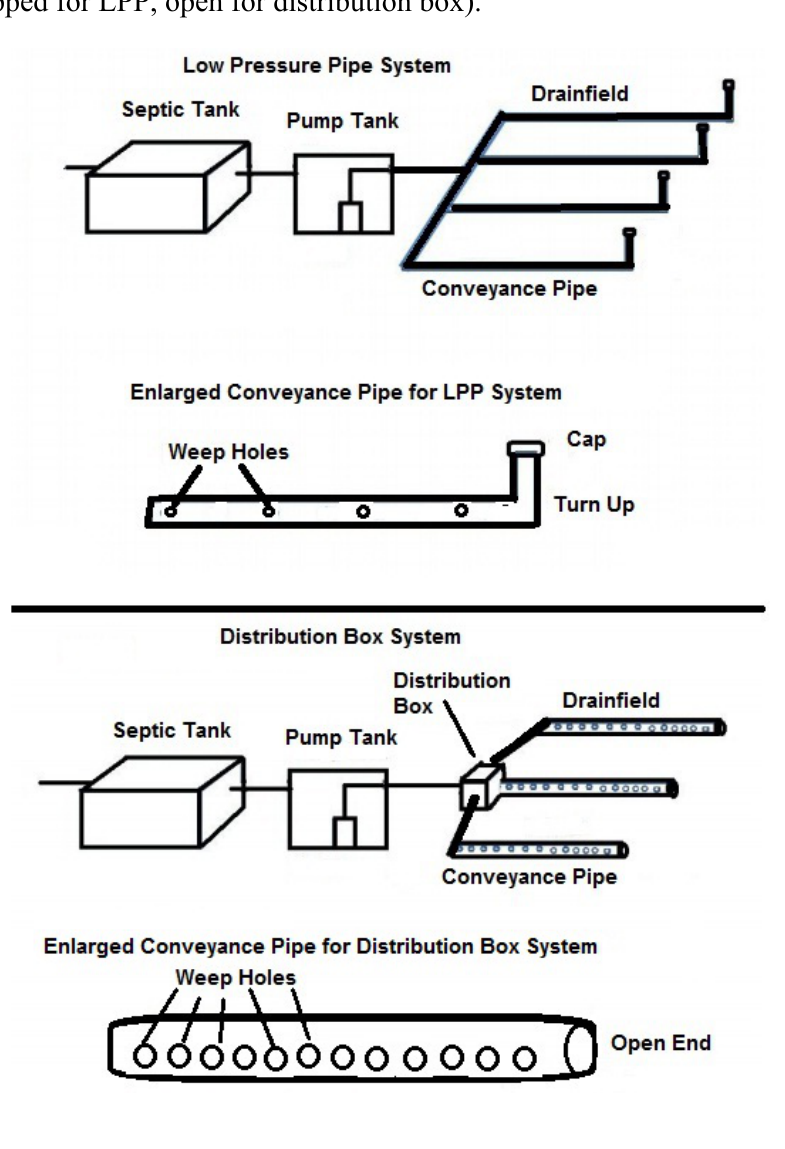
Figure 1. Low pressure pipe (LPP) system ( top ) and pump to distribution box system ( bottom ) showing the differences in pipe diameter, weep hole size and spacing, and end of the pipes (capped for LPP, open for distribution